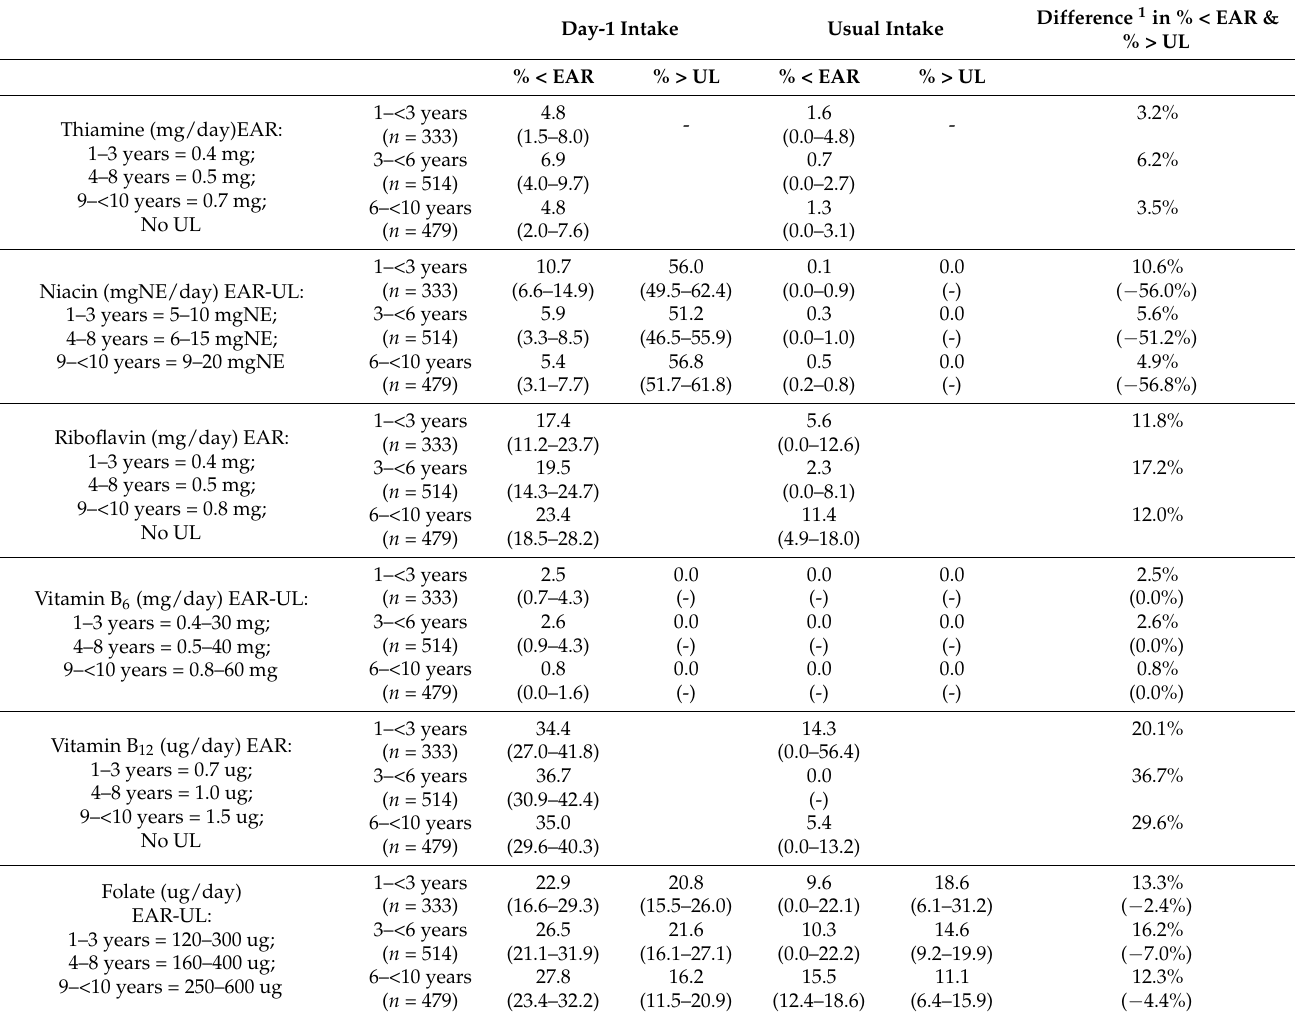
Table 11. Comparison of percentage below EAR and above UL cut-points for risk of thiamine, niacin, riboflavin, vitamin B6, vitamin B12 and folate deficiency and excess (where applicable), by age group. Difference 1 in % < EAR & Day-1 Intake Usual Intake % > UL % < EAR % > UL % < EAR % >